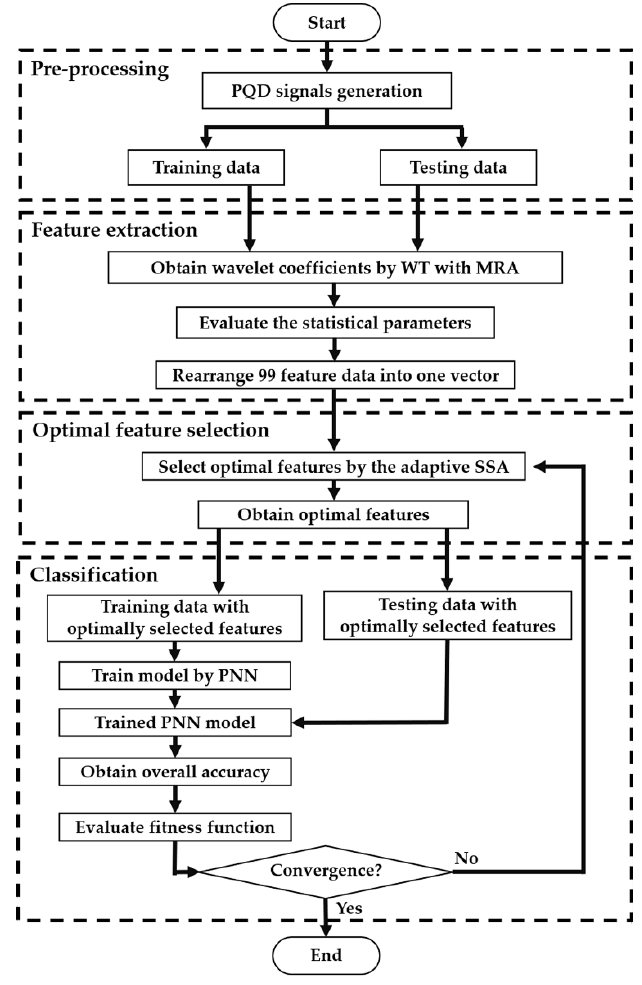
Figure 1. PQD classification scheme.